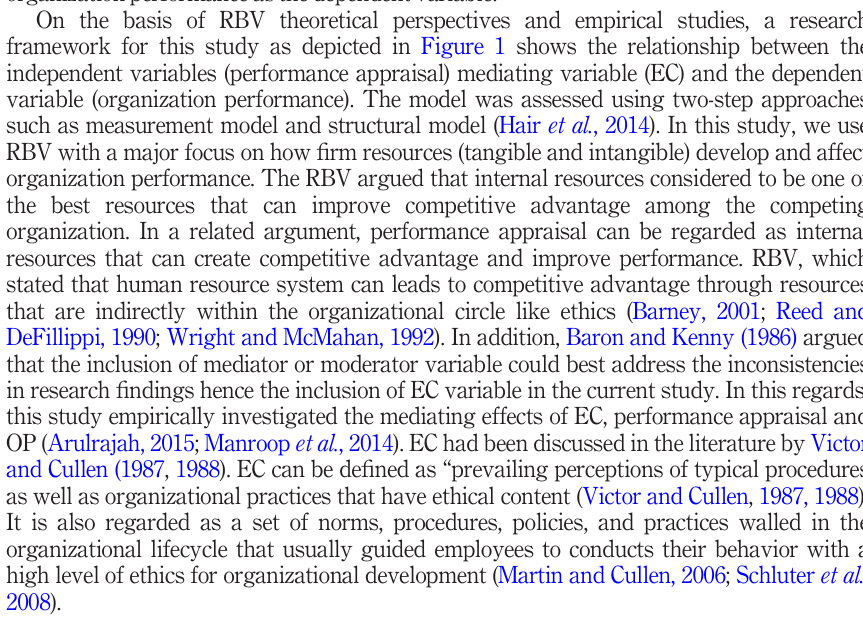
PerformanceEthical